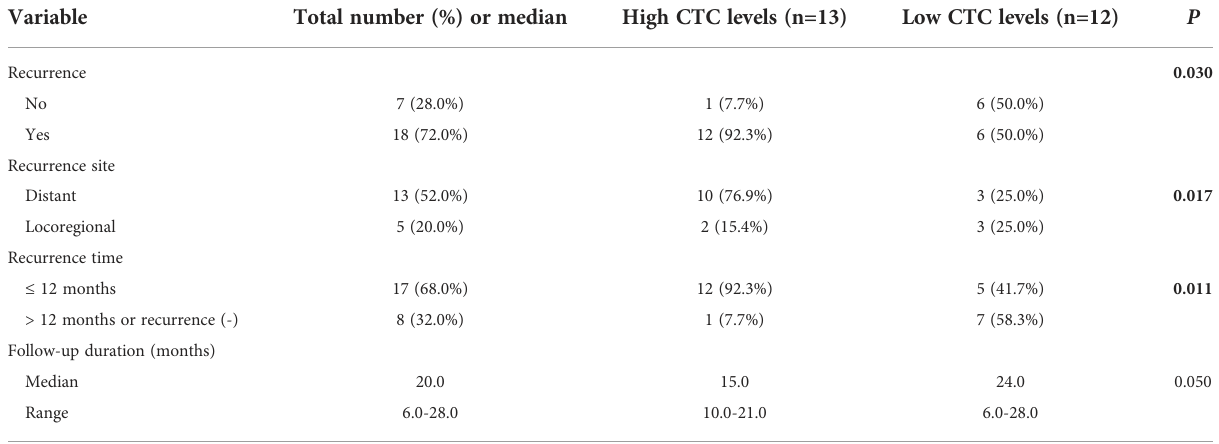
TABLE 4 Subanalysis of the recurrence patterns according to the CTC levels.